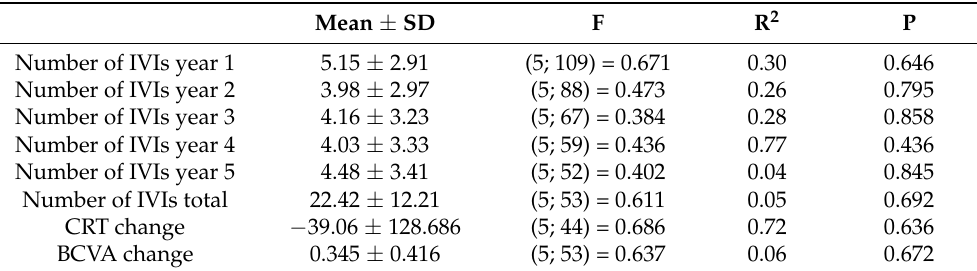
Table 4. Multiple logistic regression model. Clinical outcomes were used as dependent variables; the analyzed antibodies served as independent variables. BCVA, best-corrected visual acuity; CRT, central retinal thickness; IRF, intraretinal fluid; IVI, intravitreal injections; SD, standard deviation; SRF, subretinal fluid.